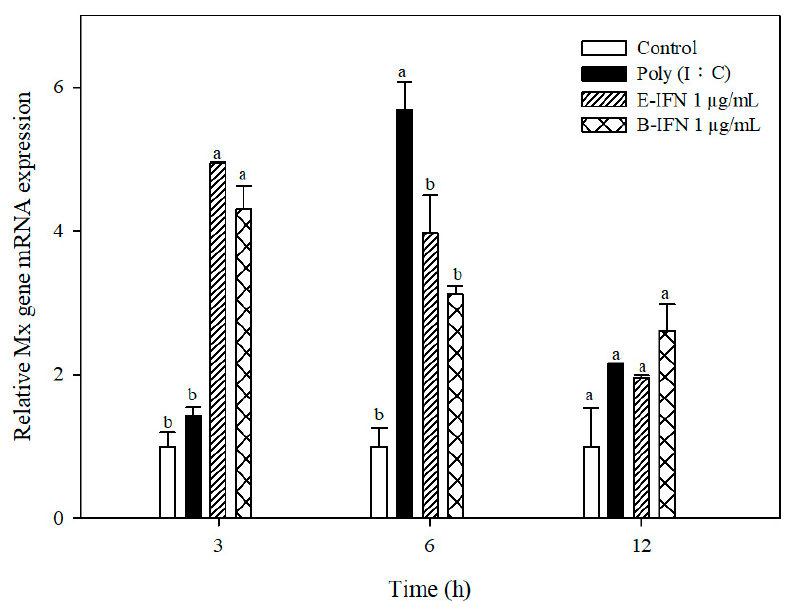
Figure 6. Mx gene expression in the GK cells treated with recombinant IFNs. Mx gene expression at 3, 6, and 12 h in GK cells treated with 50 µ g / mL of poly(I:C) or 1 µ g / mL of E-IFN and B-IFN were measured by real-time PCR. The results were normalized against β -actin gene and data of triplicate samples were expressed as the mean fold increase relative to the control. Cells cultured with medium; 2 – ΔΔ CT method. Data are expressed as mean ± SD from triplicate experiments. Different letters in each grouped bars indicated significant differences ( p < 0.05).